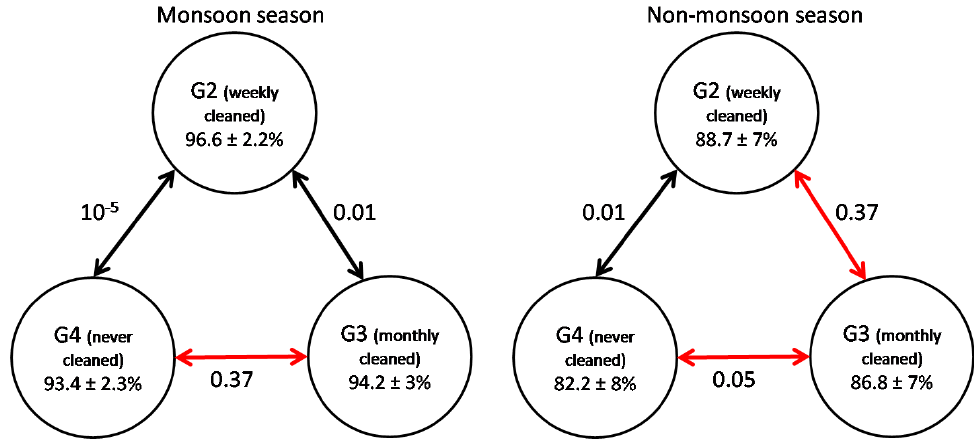
Figure 6. The t -test analysis between different cleaning cycles: weekly cleaned (G2), monthly cleaned (G3), and never cleaned (G4) glass coupons for the monsoon (left) and non-monsoon (right) seasons. The p -value is given, as well as the average and standard deviation (refer to Table 1).